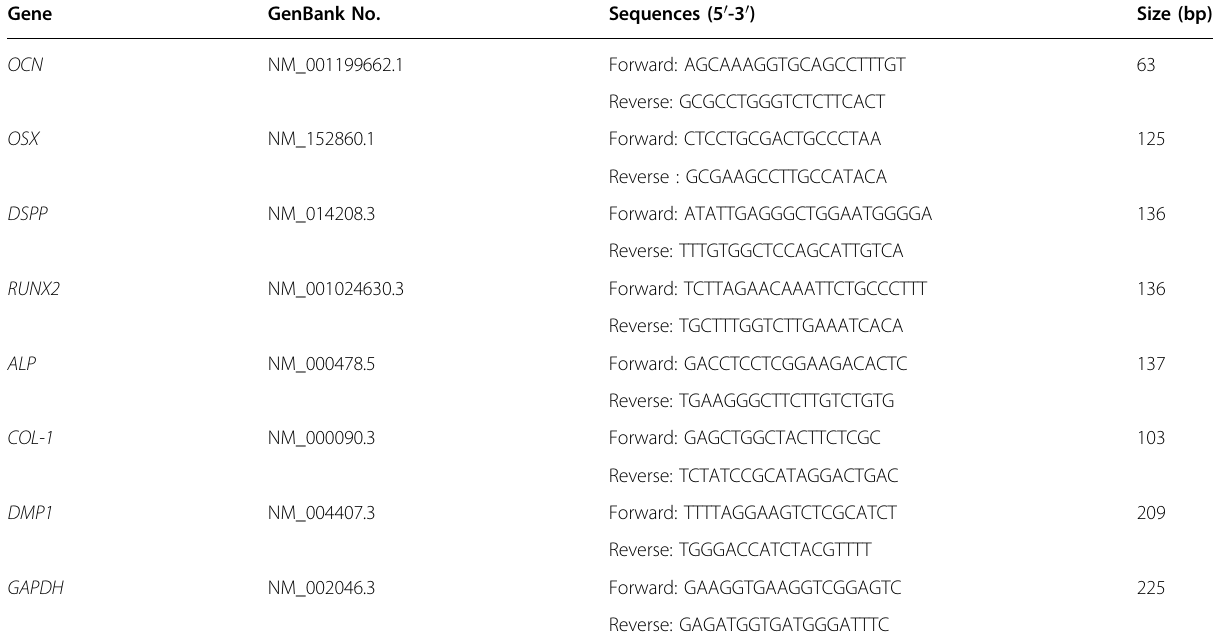
Table 1 Sense and antisense primers for real-time RT-PCR Gene GenBank No. Sequences (5 ′ -3 ′